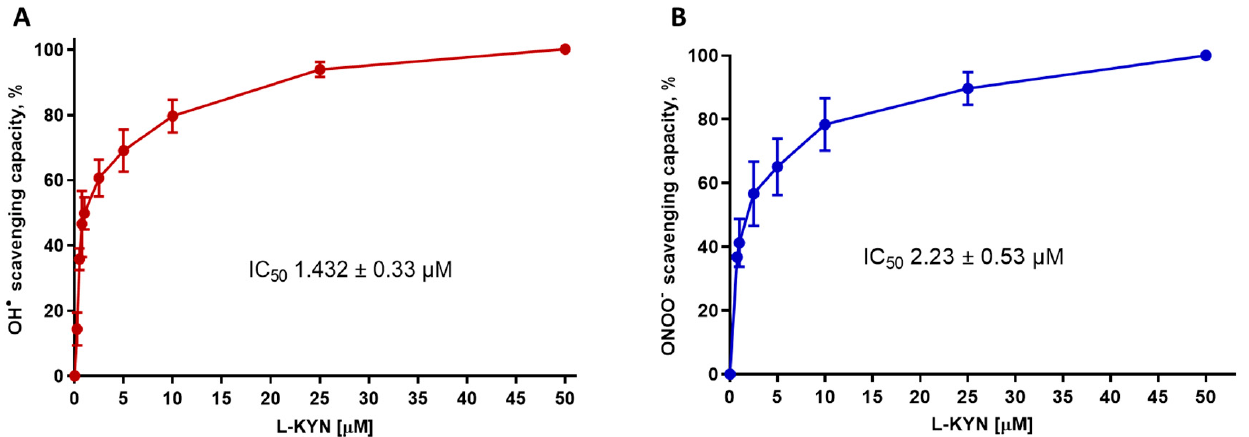
Figure 2. L-kynurenine (L-KYN) (1–50 µ M) ability to scavenge ( A ) hydroxyl radical ( • OH) and ( B ) peroxynitrite (ONOO − ) in a chemical combinatory system. Data are presented as mean values ± S.E.M. of 6 experiments per concentration.